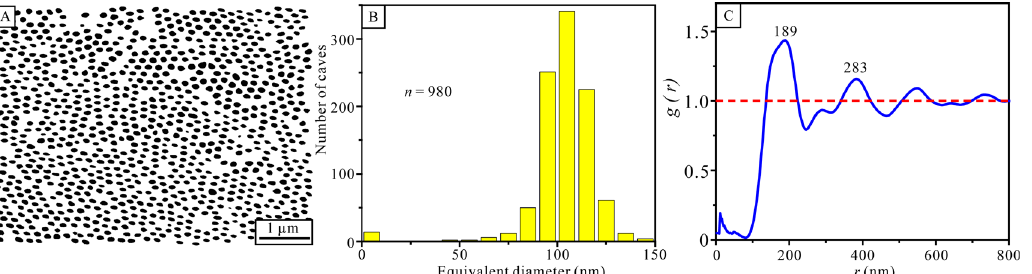
Figure 5. ( A ) Binary image of Figure 4E. ( B ) Histogram of the distribution of fibers’ equivalent diameter. ( C ) Pair correlation function of fiber centroids.